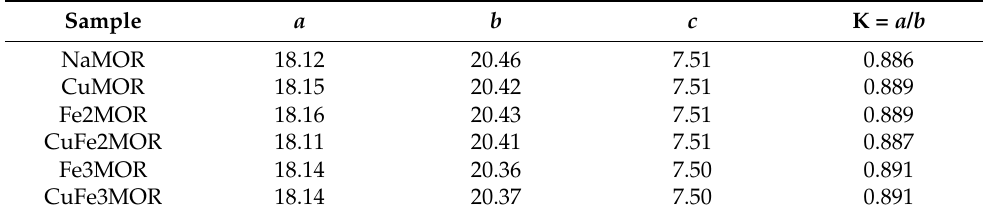
Table 1. Lattice parameters of mordenite before and after ion